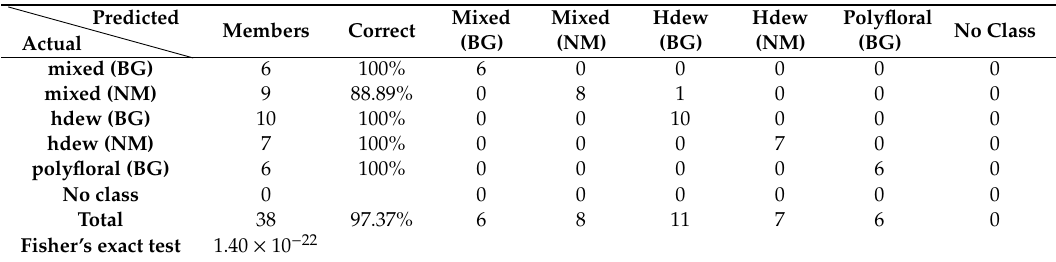
Table 2. Misclassification table of mixed, honeydew (hdew), and polyfloral honeys the for PLS-DA model used